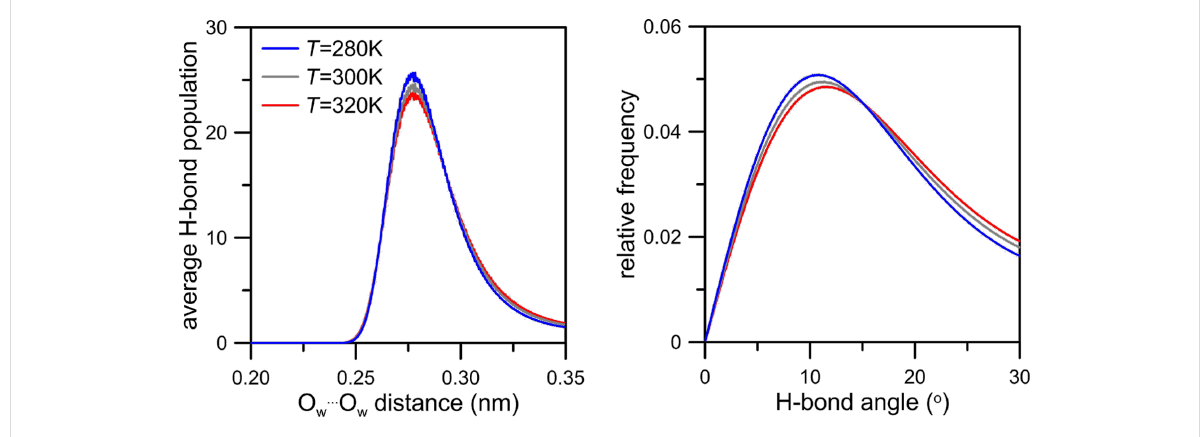
Figure 16: Temperature influence on (a) the hydrogen bond distance and (b) the angle distribution in water for an NN membrane system and a CH 4 + N 2 gaseous mixture containing 200 water molecules.